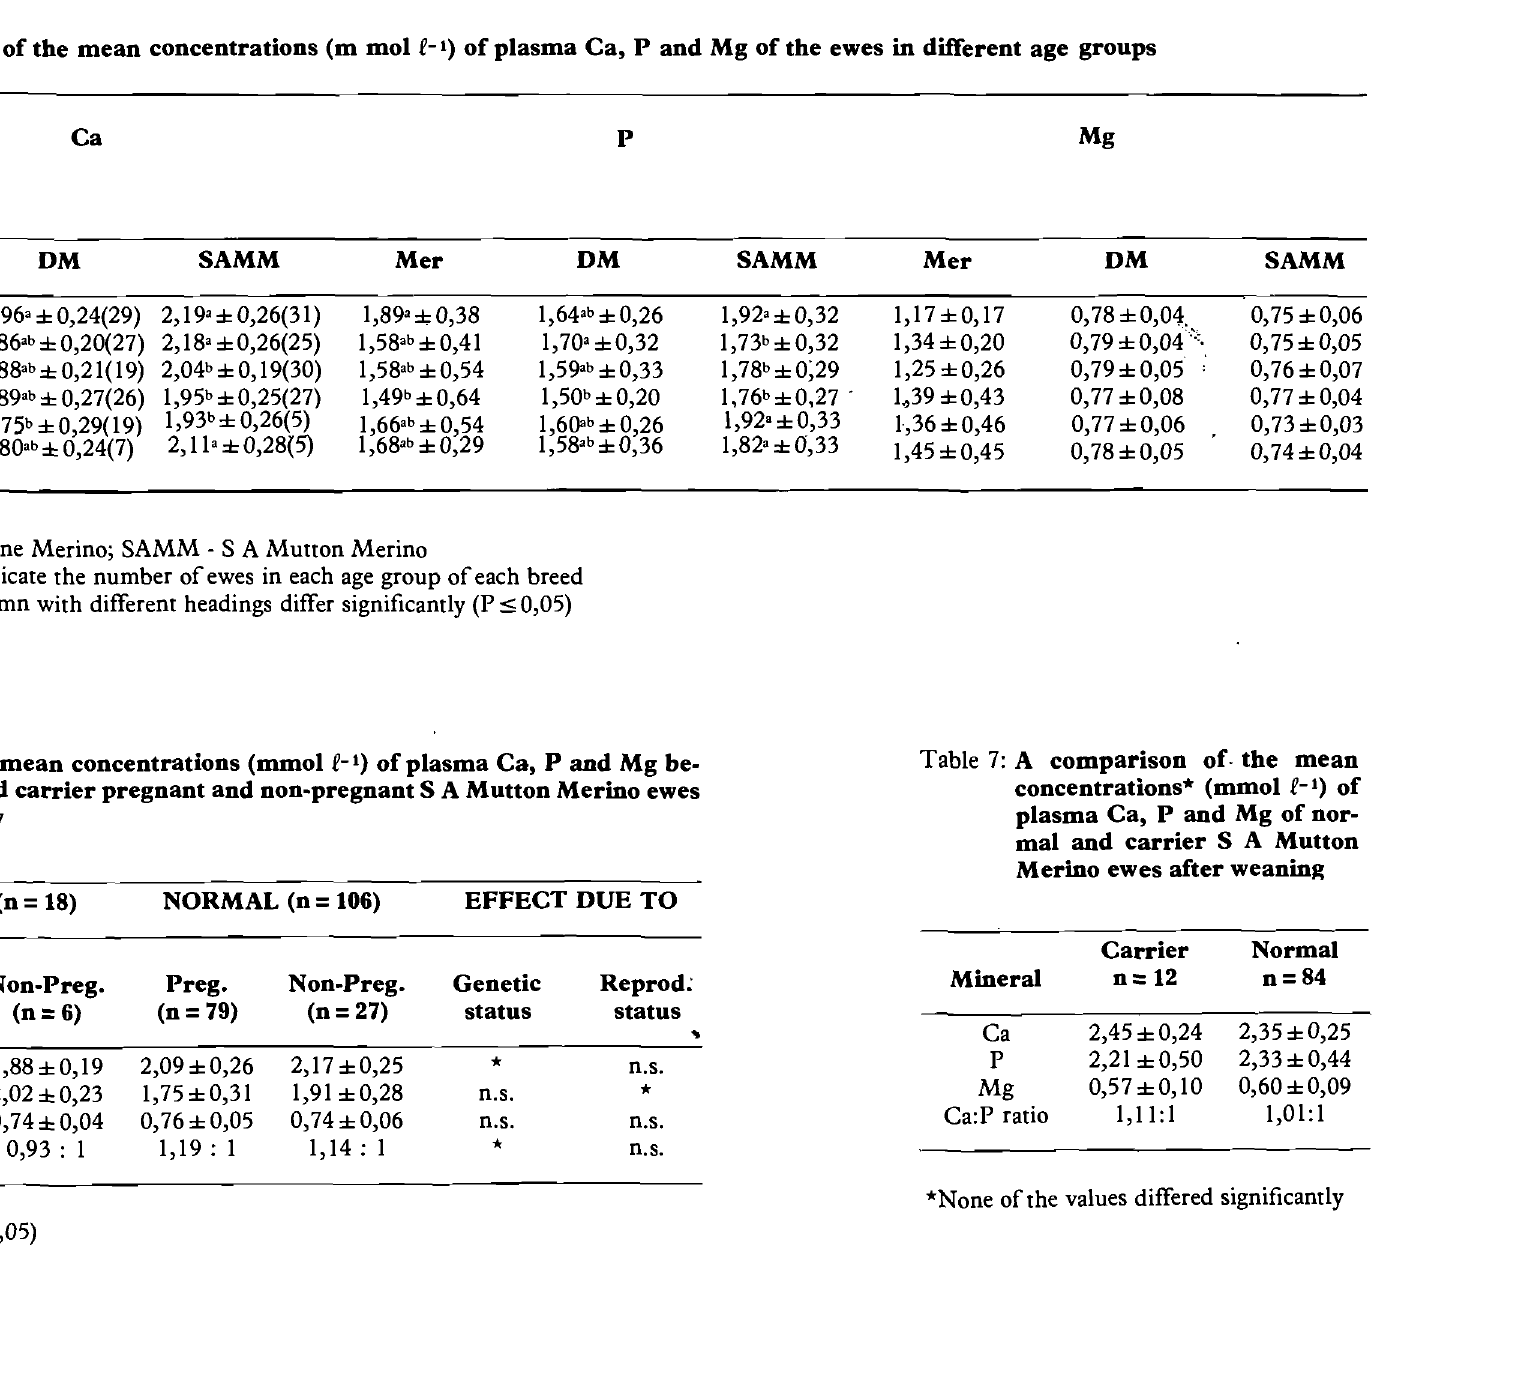
Table 5: A comparison of the mean concentrations (m mol £-1) of plasma Ca, P and Mg of the ewes in different age groups